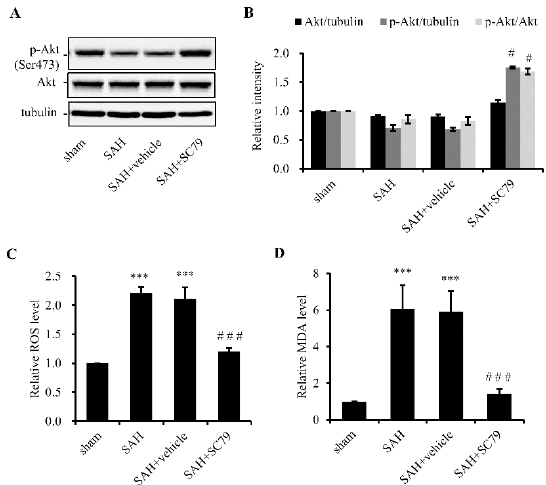
Figure 1. Akt phosphorylation by SC79 administration protects cells against oxidative stress after SAH.Arterial blood (300 µL, normal saline in the sham group) was injected into the prechiasmatic cistern of rats. DMSO (5 µL/rat) and SC79 (100 µg/rat) were given intracerbroventricularly (ICV) at 30 min after SAH as SAH + vehicle and SAH + SC79 groups, respectively. The temporal cortex was harvested 24 h after SAH. ( A ) SC79 activation of Akt by SC79, revealed with Western blotting. The left panel shows a representative result of the levels of total (Akt) and phosphorylated (p-Akt, Ser473) Akt. The right panel shows the quantitative data. Tubulin was used as a loading control; ( B , C ) show alleviation of oxidative stress by SC79 treatment. ROS production ( B ) and MDA levels ( C ) were shown. Data are expressed as mean ± SD ( n = 8 in each group). *** p < 0.001 vs. the sham group, # p < 0.05 and ### p < 0.001 vs. the SAH group. SAH, subarachnoid hemorrhage; ROS, reactive oxidative species; MDA, malondialdehyde.